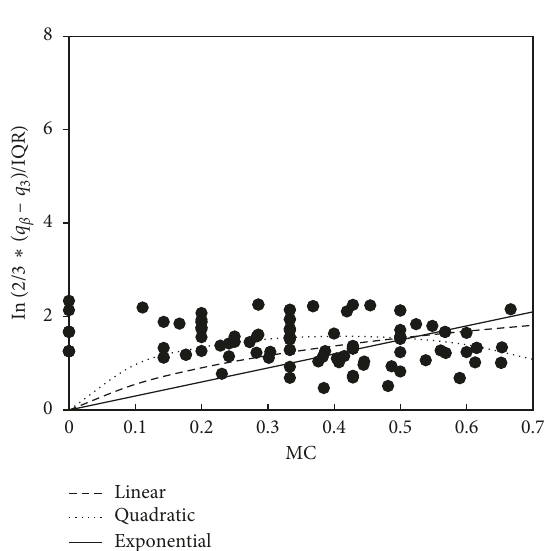
Figure 3: The fit of the lower boundary.